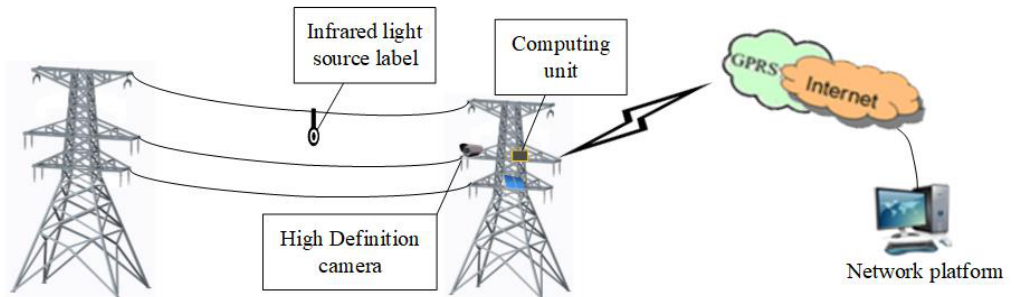
Figure 1. System framework diagram.